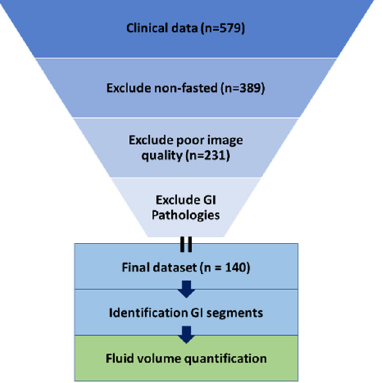
Figure 1. Visualization of the methodology used. Table 1. Exclusion criteria with their respective number of excluded